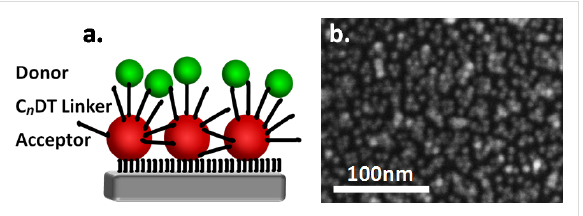
Figure 1: (a) A scheme of the investigated systems in which large CdSe NPs (acceptors) were assembled on quartz substrates by mercaptosilane monolayers. Dithiols of various lengths (C n DT) were then adsorbed on the first layer of the NPs followed by adsorption of a second layer of small CdSe NPs (donors). (b) SEM image of an acceptor NPs monolayer adsorbed on a Si/SiO 2 substrate.